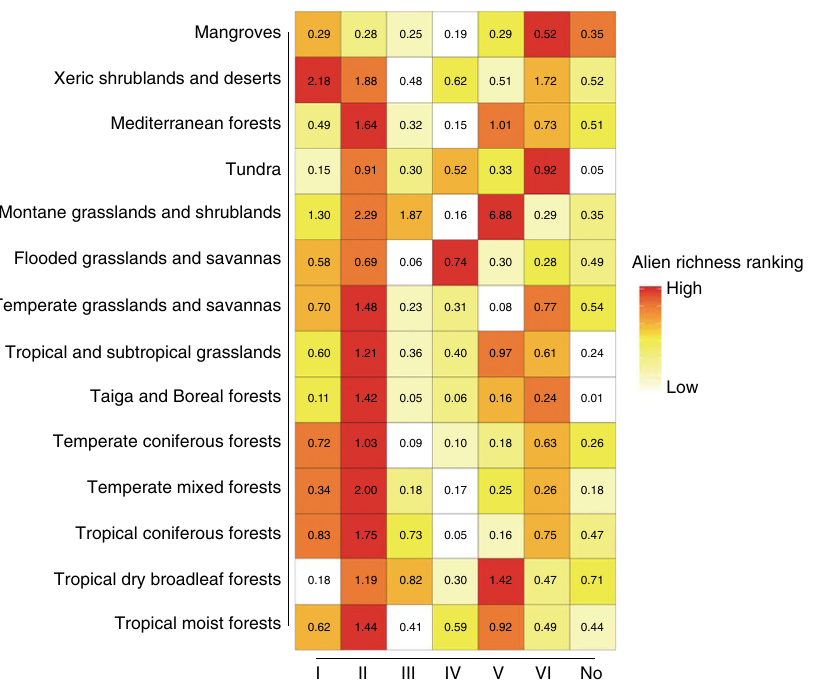
Fig. 4 Heatmap showing the ranking of average richness of established alien animal species across IUCN conservation categories in 14 global biomes. The colour scale was determined by ranking the average established alien animal species richness (in brackets) of PAs with different IUCN conservation categories in each of 14 biomes. Detailed values for each taxon are provided in Supplementary Fig. 4.